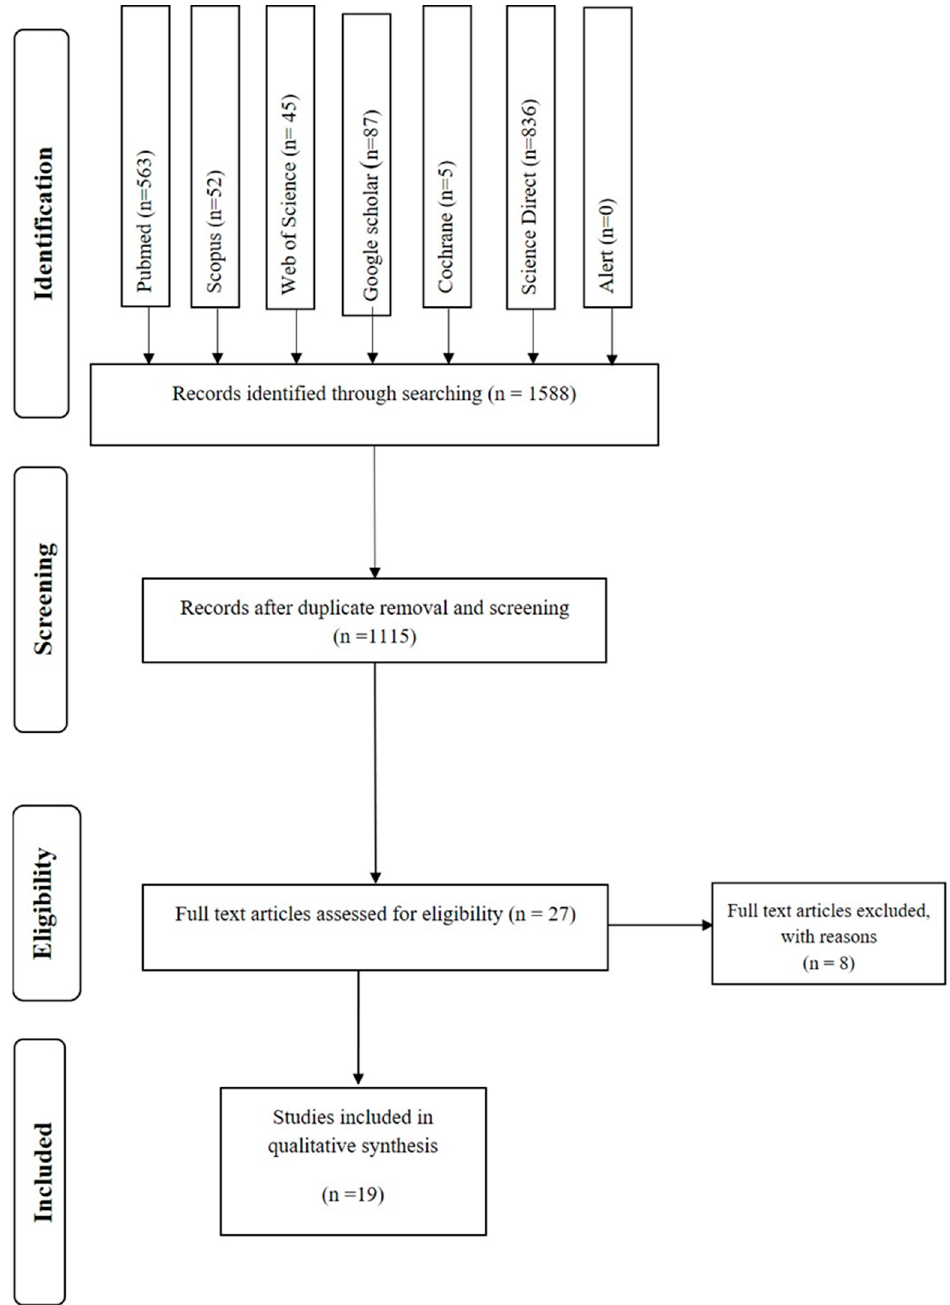
Figure 2. Prisma Flowchart. Note. Adapted PRISMA fl ow diagram of the study selection.